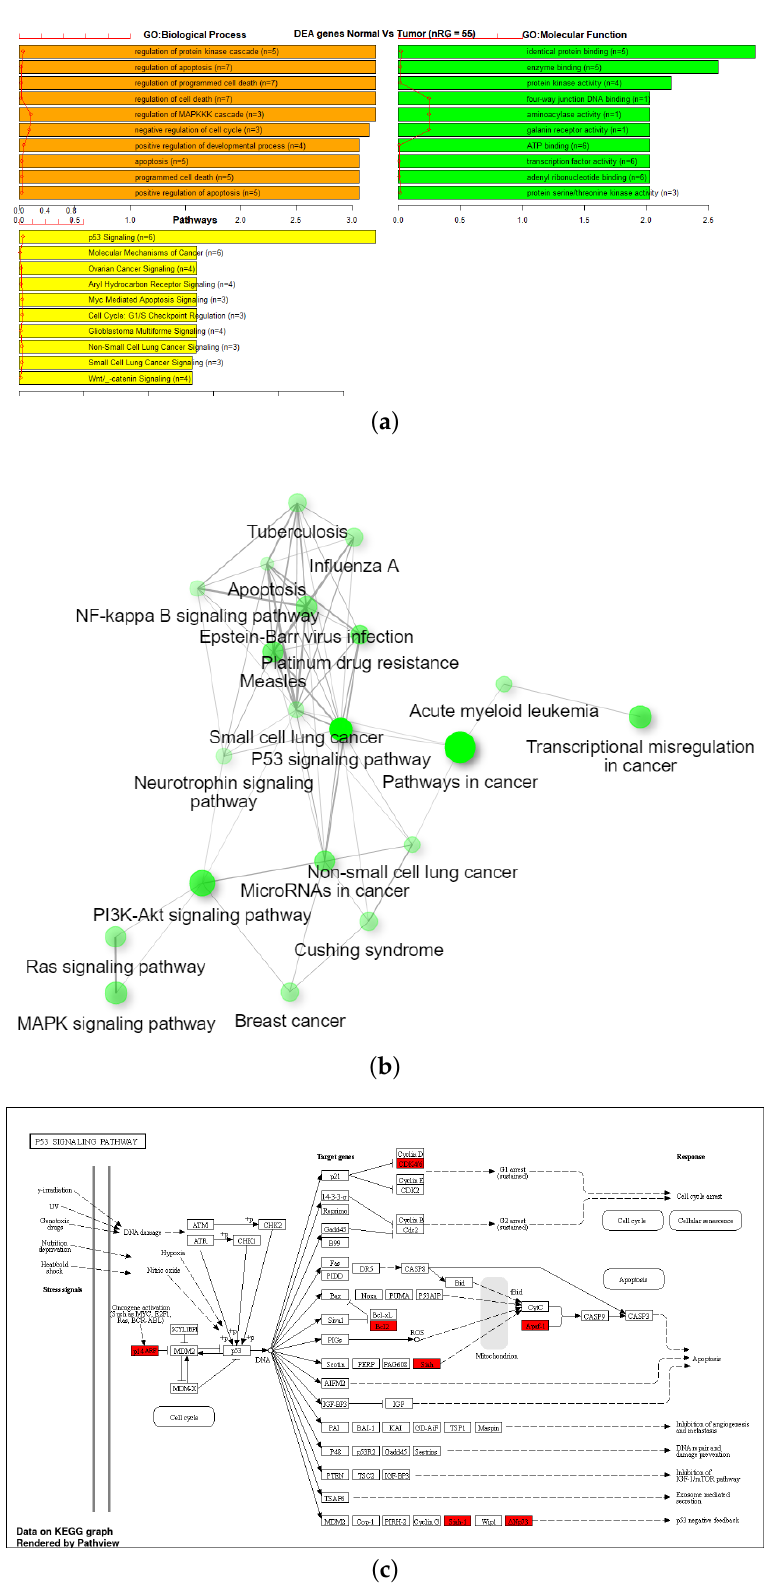
Figure 8. GSEA on Tumor suppressor/oncogene overlap subset of 27K with SMOTE, using ( a ) TCGA EAanalysis where orange represents biological processes, green is molecular functions, and yel- low represents pathways, ( b ) ShinyGO with network visualization of functional associations, and ( c ) ShinyGO enriched pathway visualization where red genes are in the gene set